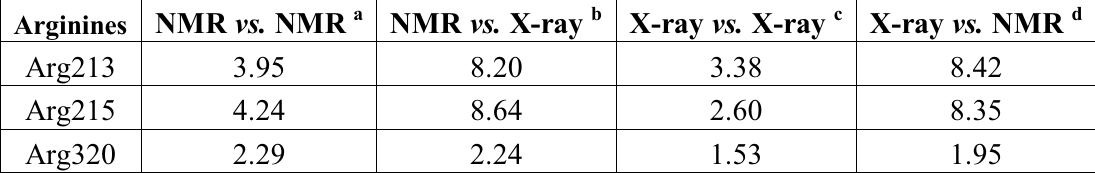
Table 3. Main-chain RMSD of three arginines after 20-ns MD